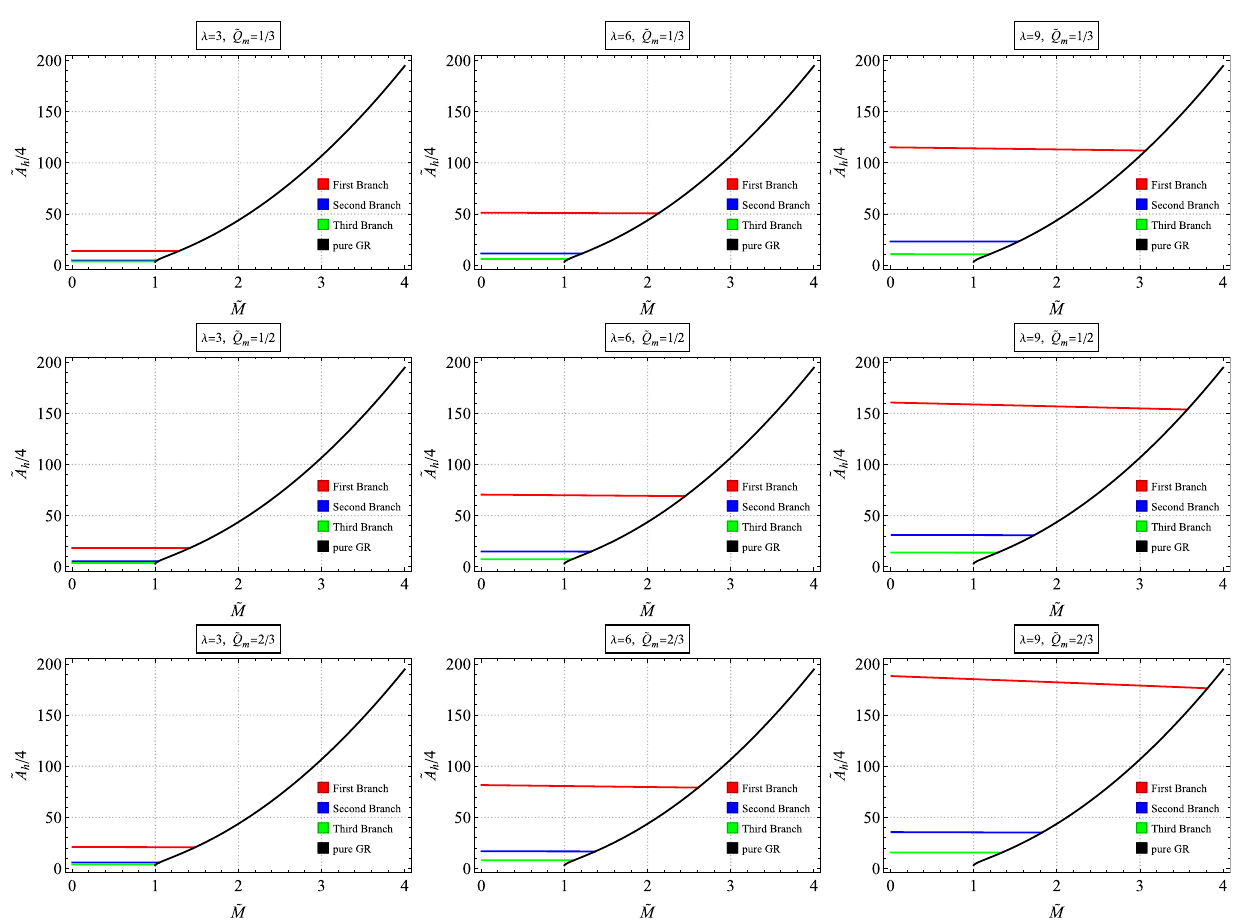
Fig. 7 Plots show the reduced entropy ˜ A h / 4 of black holes as a function of its reduced mass ˜ M with different values of the coupling constant λ and reduced magnetic charge ˜ Q m for the first three branches of scalarized dyonic RN black